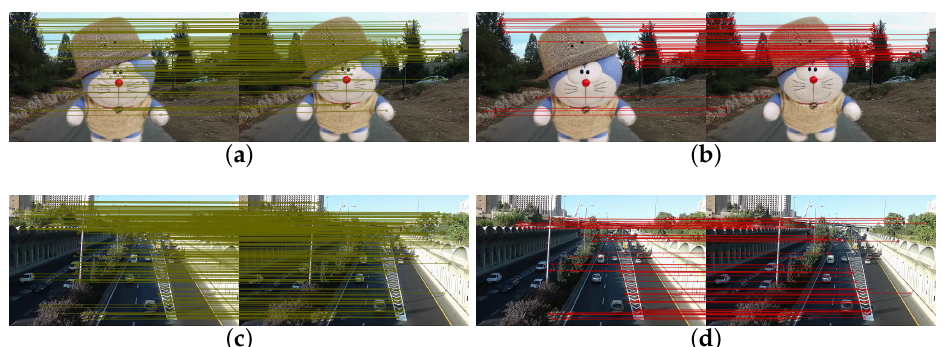
Figure 5. Feature point matching: ( a ) using RANSAC in large object occlusion shaky video, ( b ) proposed method in large object occlusion shaky video, ( c ) using RANSAC in multiply objects shaky video, ( d ) proposed method in multiply objects shaky video.